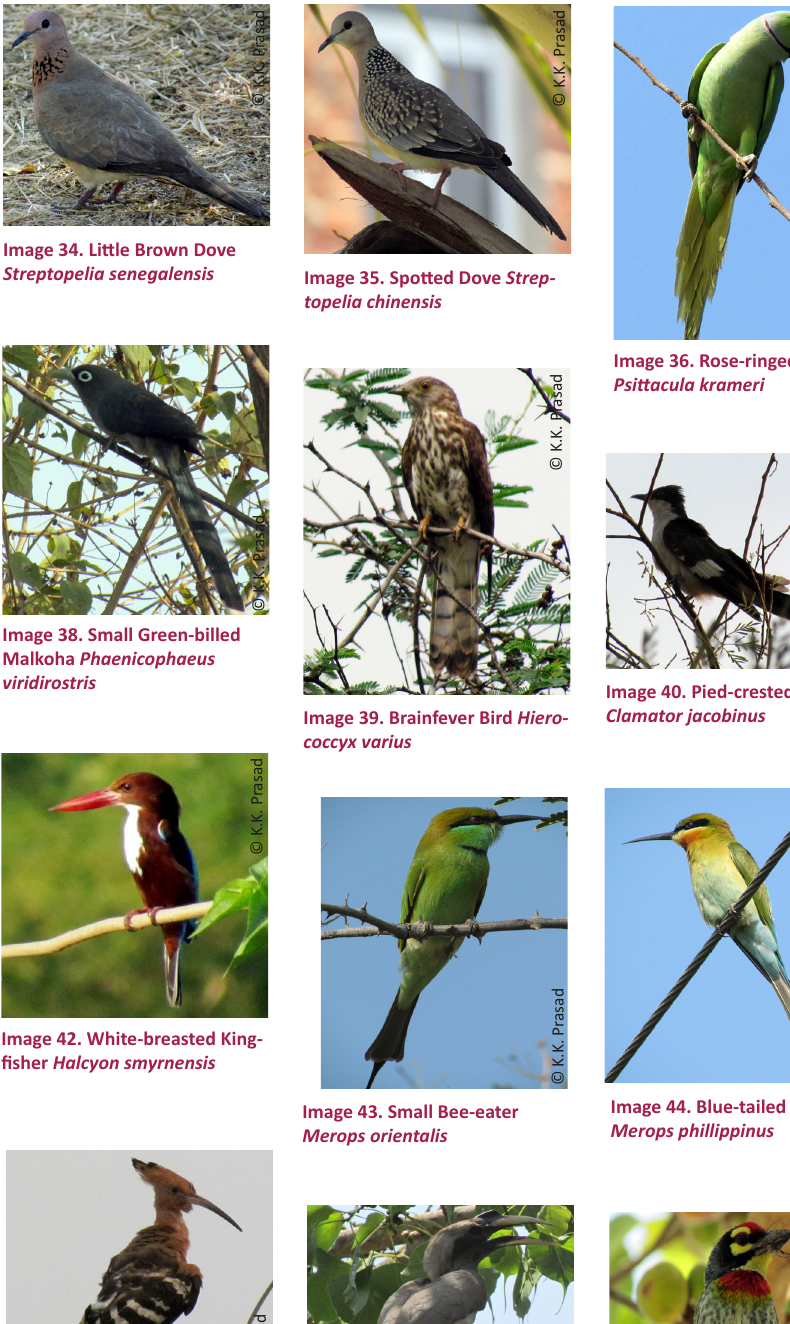
Image 46. Common Hoopoe Upupa epops